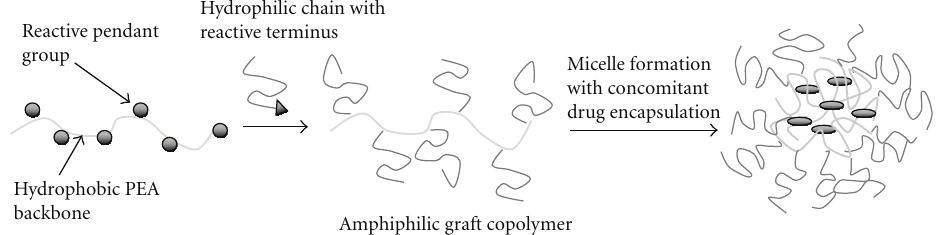
Figure 1: Schematic for the preparation of amphiphilic PEA graft copolymers and their assembly into micelles for drug delivery.